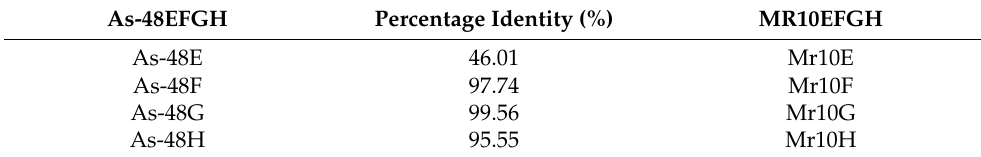
Table 2. Comparison between MR10A/B and AS-48 pump-forming proteins. The table represents the similarity observed between the ABC transporter proteins of MR10A/B and AS-48. As-48EFGH Percentage Identity